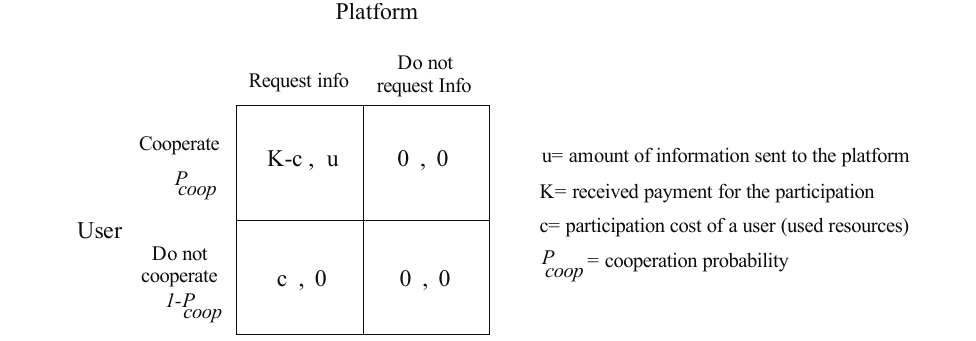
Figure 5. Game theoretic representation of our problem as a mixed strategy game.